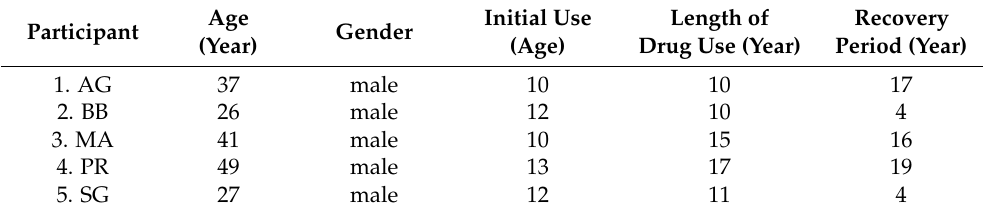
Table 2. Demographic characteristics and drug